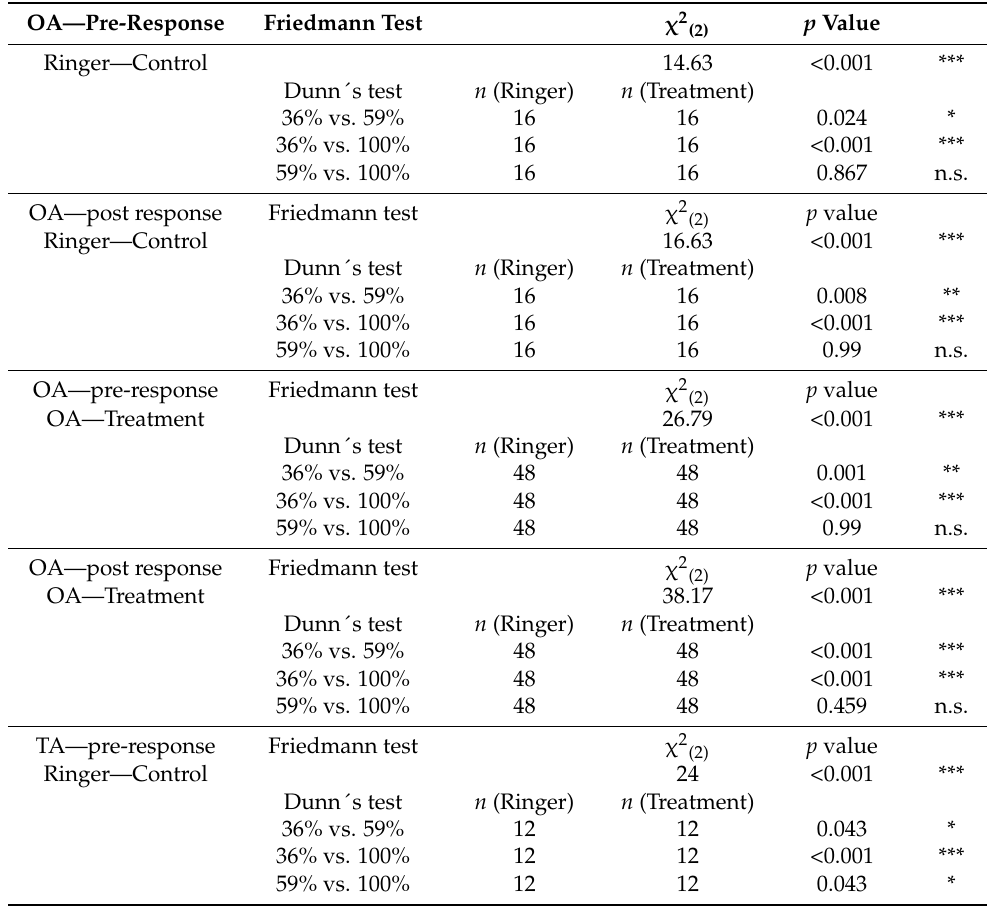
Table 1. Analysis of the ERG response of three light intensity filters before and after the application of octopamine/tyramine (treatment) or Ringer